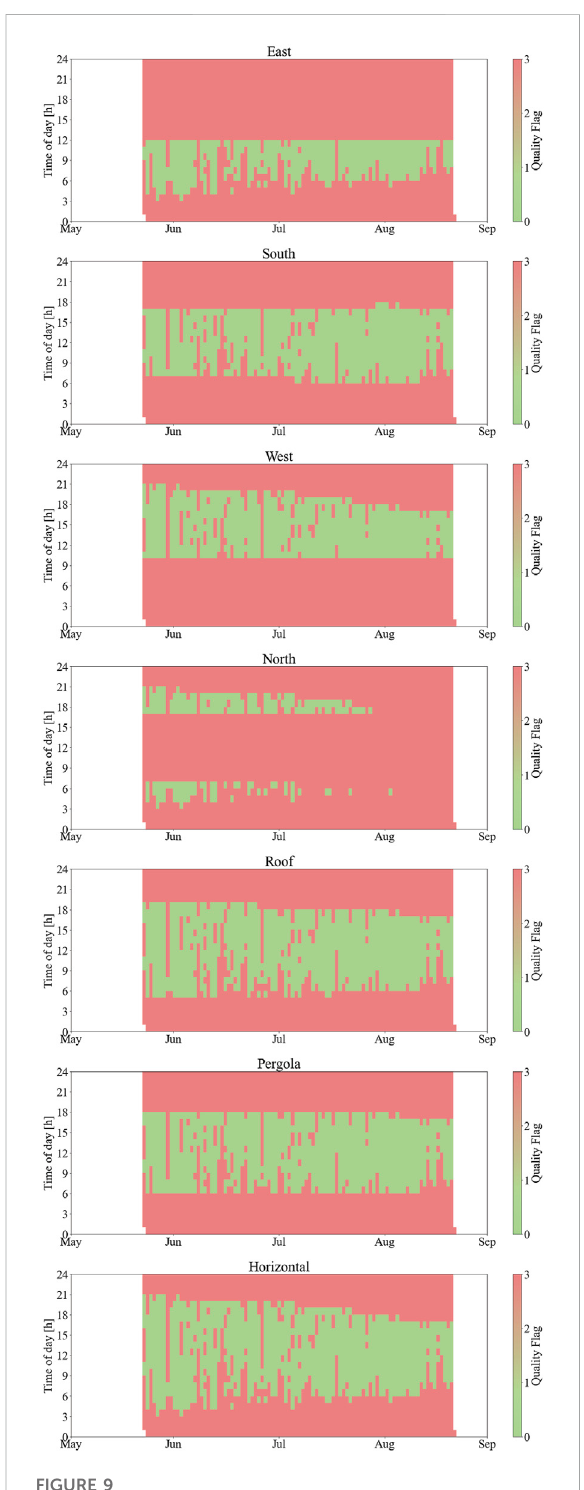
FIGURE 9 Overview of the quality fl ags associated with the datapoints.